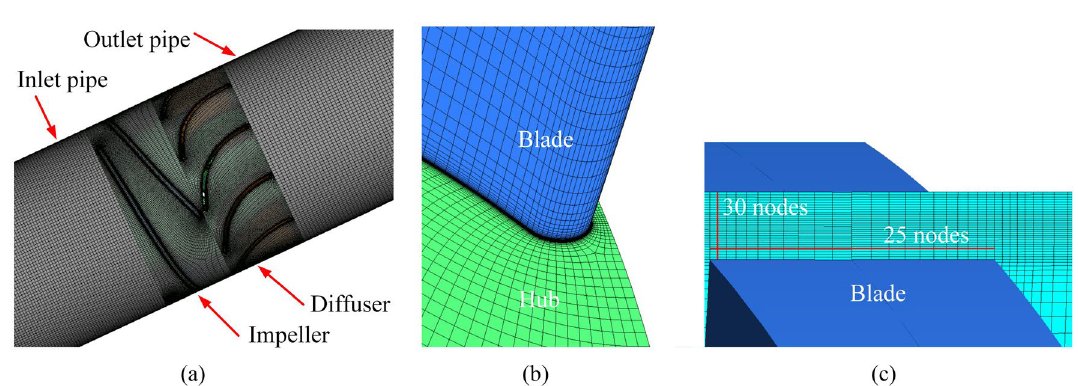
Figure 3. Computational grid. ( a ) Whole computational domain, ( b ) impeller blade, and ( c ) tip